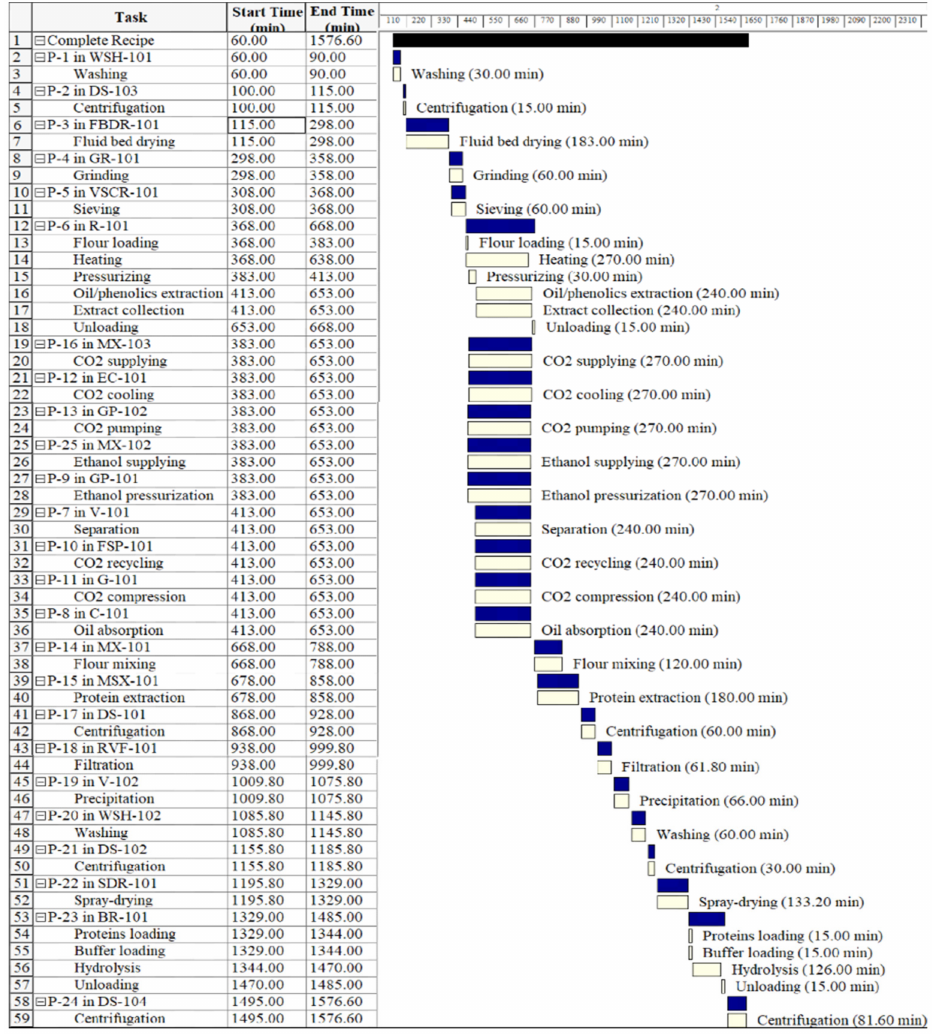
Figure 2. Industrial operations Gantt chart for obtaining QPH by supercritical fluids’ extraction